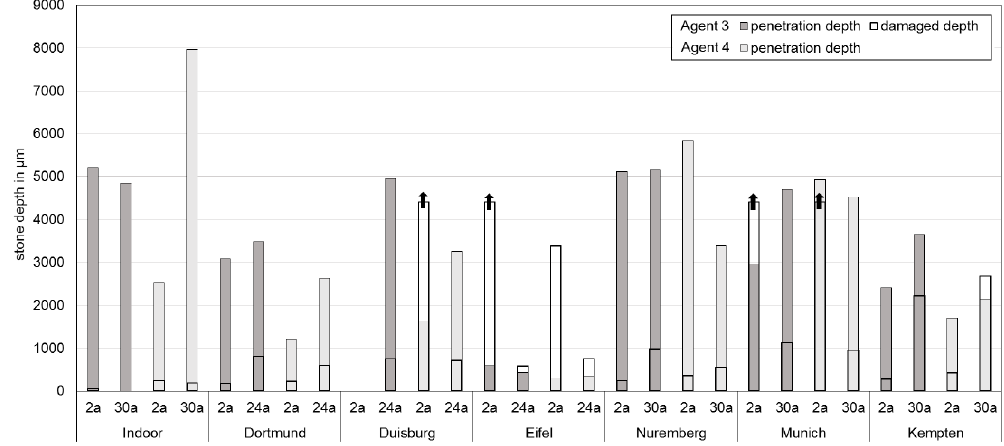
Figure 13. Comparison of the penetration depth of agents 3 or 4 applied on OKS with the damaged depth calculated with Equation (5) (depth 0 = surface of the stone).